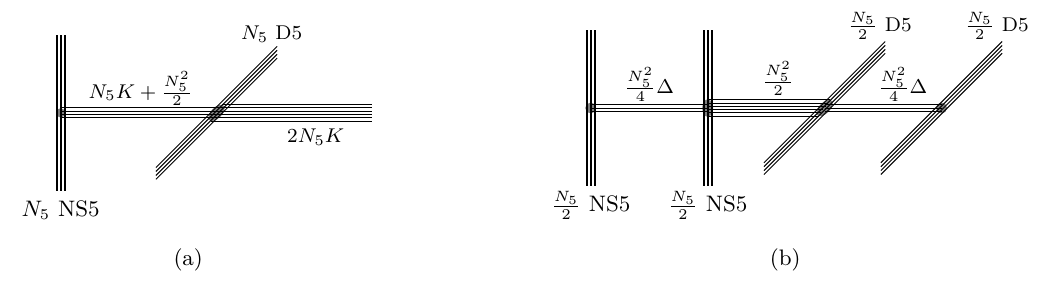
Figure 4 . Brane configurations for representative non-gravitating bath solutions (left) and gravi- tating bath solutions (right). Hanany-Witten transitions can be used to make the 3d quiver gauge theories more apparent, as in figures 2, 3. The numbers of D3-branes on the right are controlled by δ through ∆ = 1 + 2 arctan e 2 δ 2 π